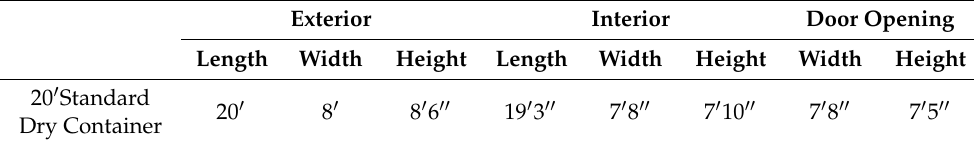
Table 4. Standard ISO Container Dimensions. Exterior Interior Door Opening